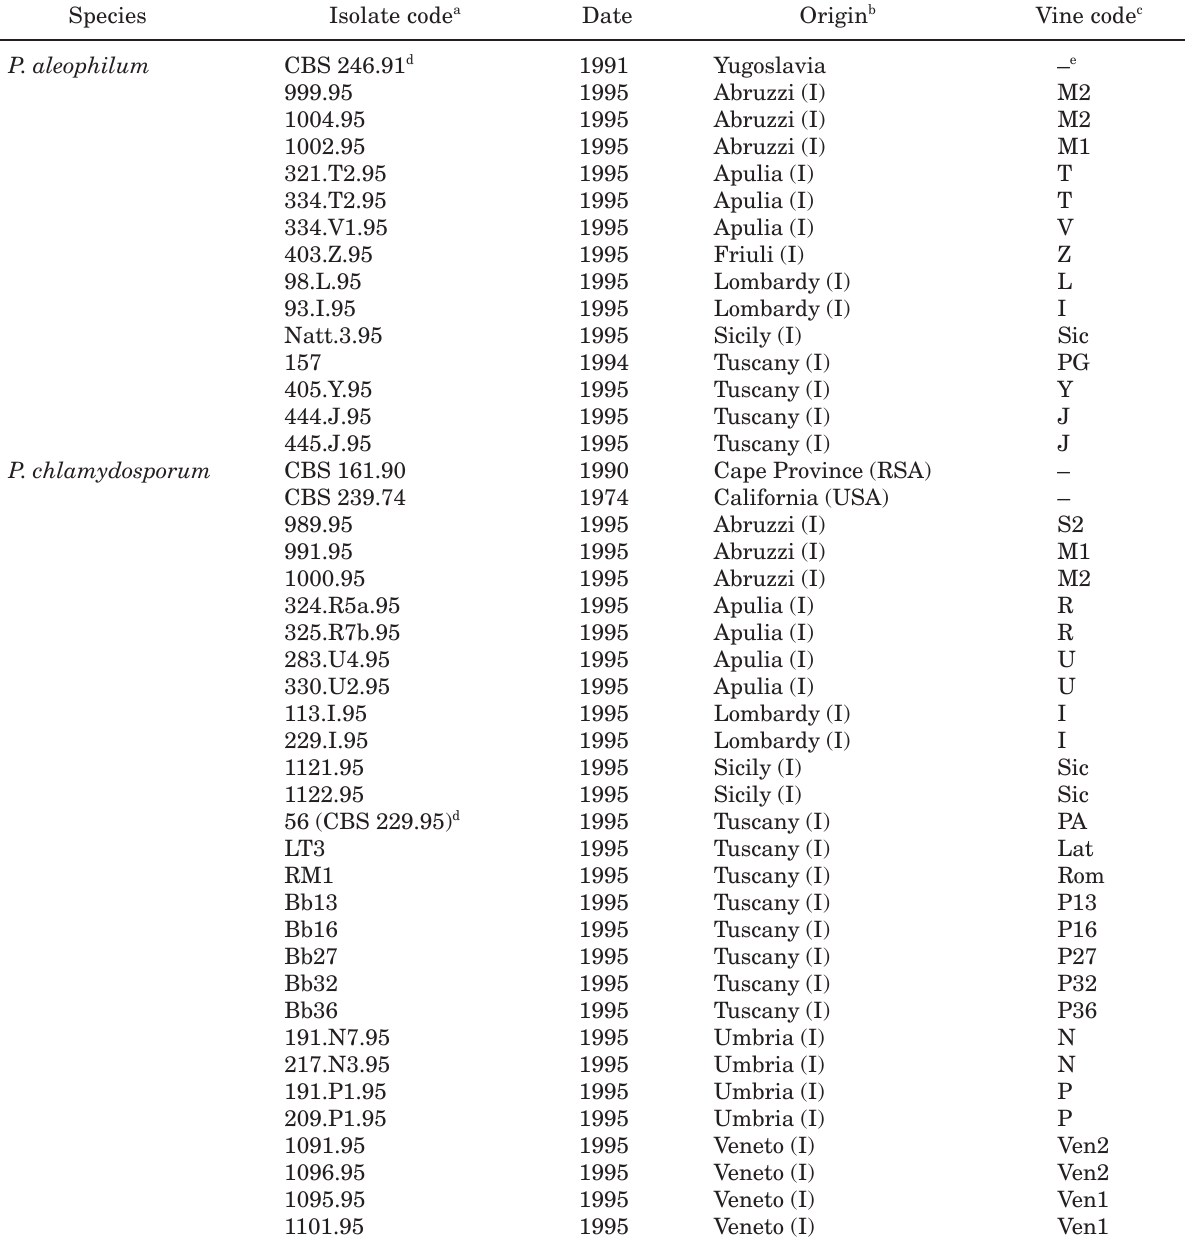
Table 1. Isolate designation, sampling date, geographic origin, and host plant of Phaeoacremonium spp. used in this